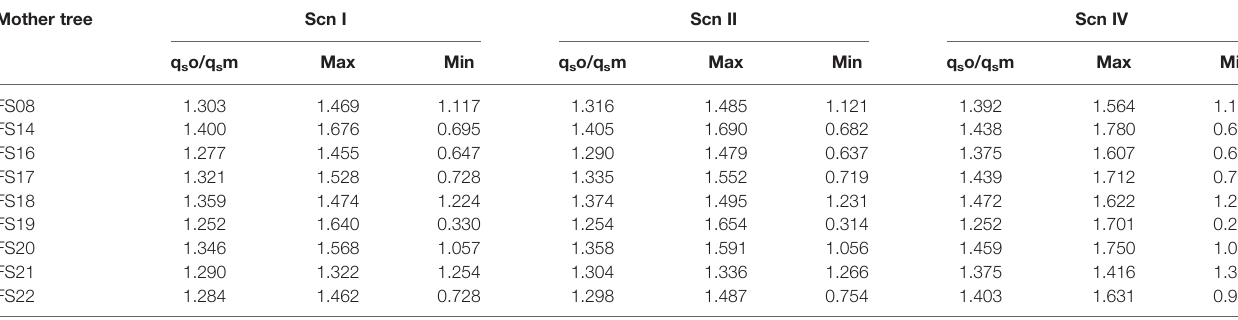
TABLE 3 | Ratio between S TRUCTURE ’ s q s of the offspring and q s of their mothers under each scenario. Mother tree Scn